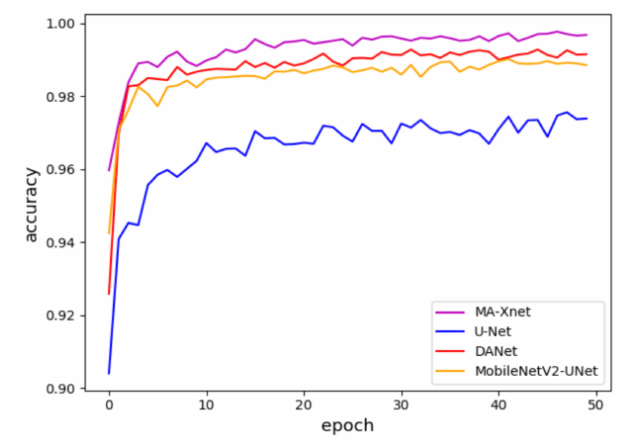
Figure 6. Pixel accuracy curve comparison.